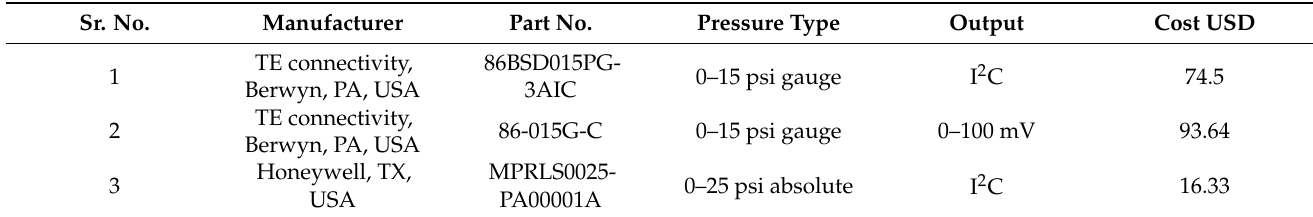
Table 1. List of short-listed pressure